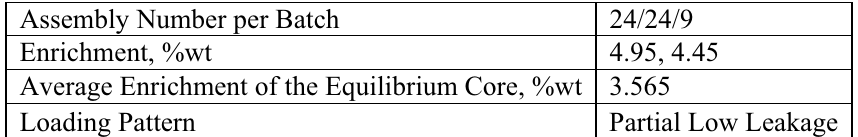
Figure 5. Loading Pattern of ACP100 (1/4 core) Table II.: Fuel Management Design of Boron and CRs Co-controlled Core